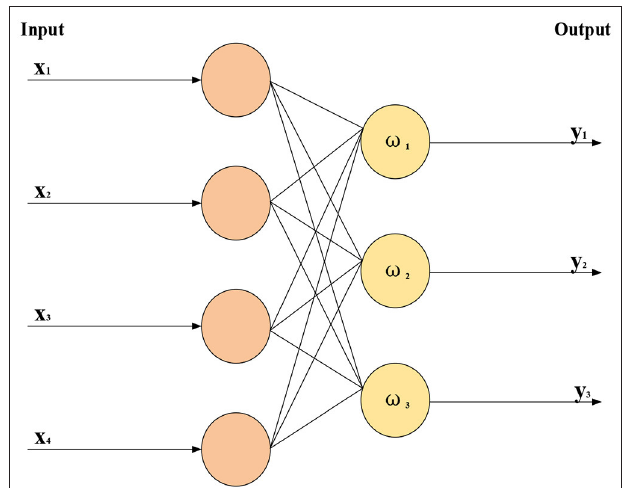
FIGURE 6 | Structure of simple neural